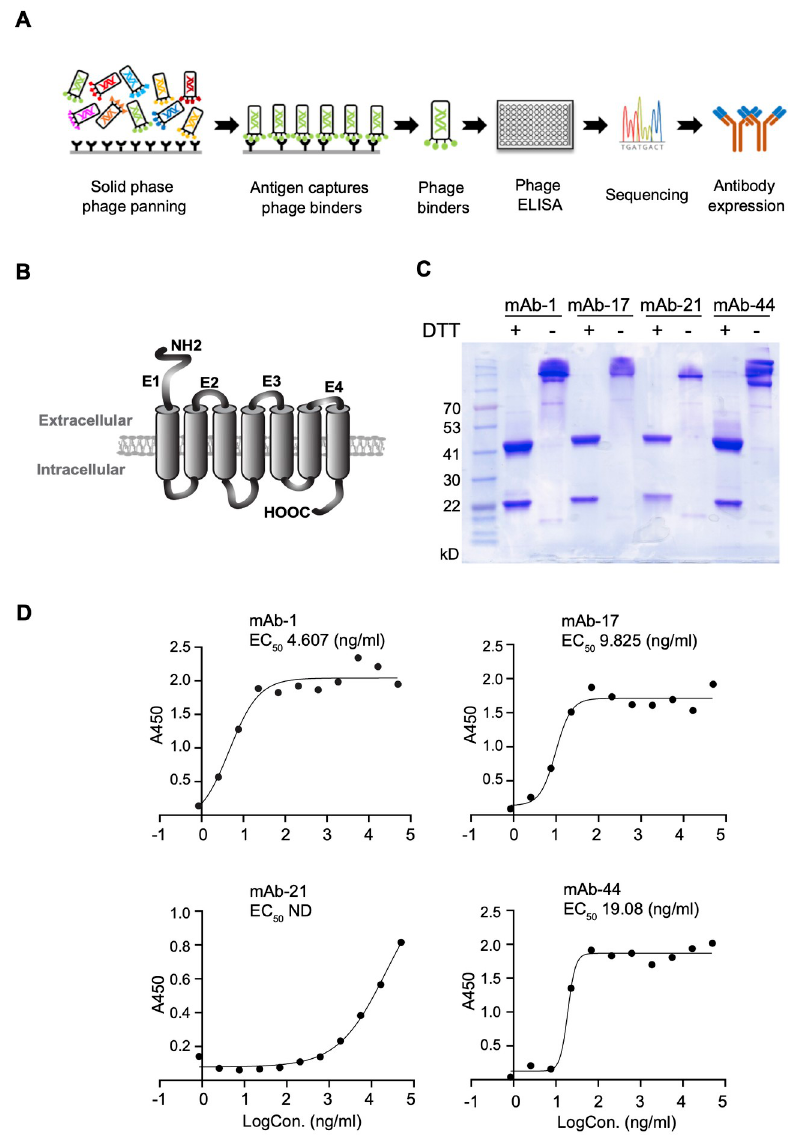
Fig 1. GRP-R monoclonal antibody development and production. (A) Human scFv phage display library screening strategy. (B) GRP-R is a G-protein coupled receptor, with seven transmembrane domains, four intracellular and four extracellular domains. We synthesized four peptides of extracellular domains (E1 to E4) for the screening phage library. (C) Purified GRP-R monoclonal antibodies were electrophorized on SDS-PAGE at non-reduced (-DTT) conditions, and heavy chain (55 kDa) and light chain (25 kDa) were separated at reduced condition (+DTT). (D) EC 50 of each GRP-R mAb was determined with titration ELISA.